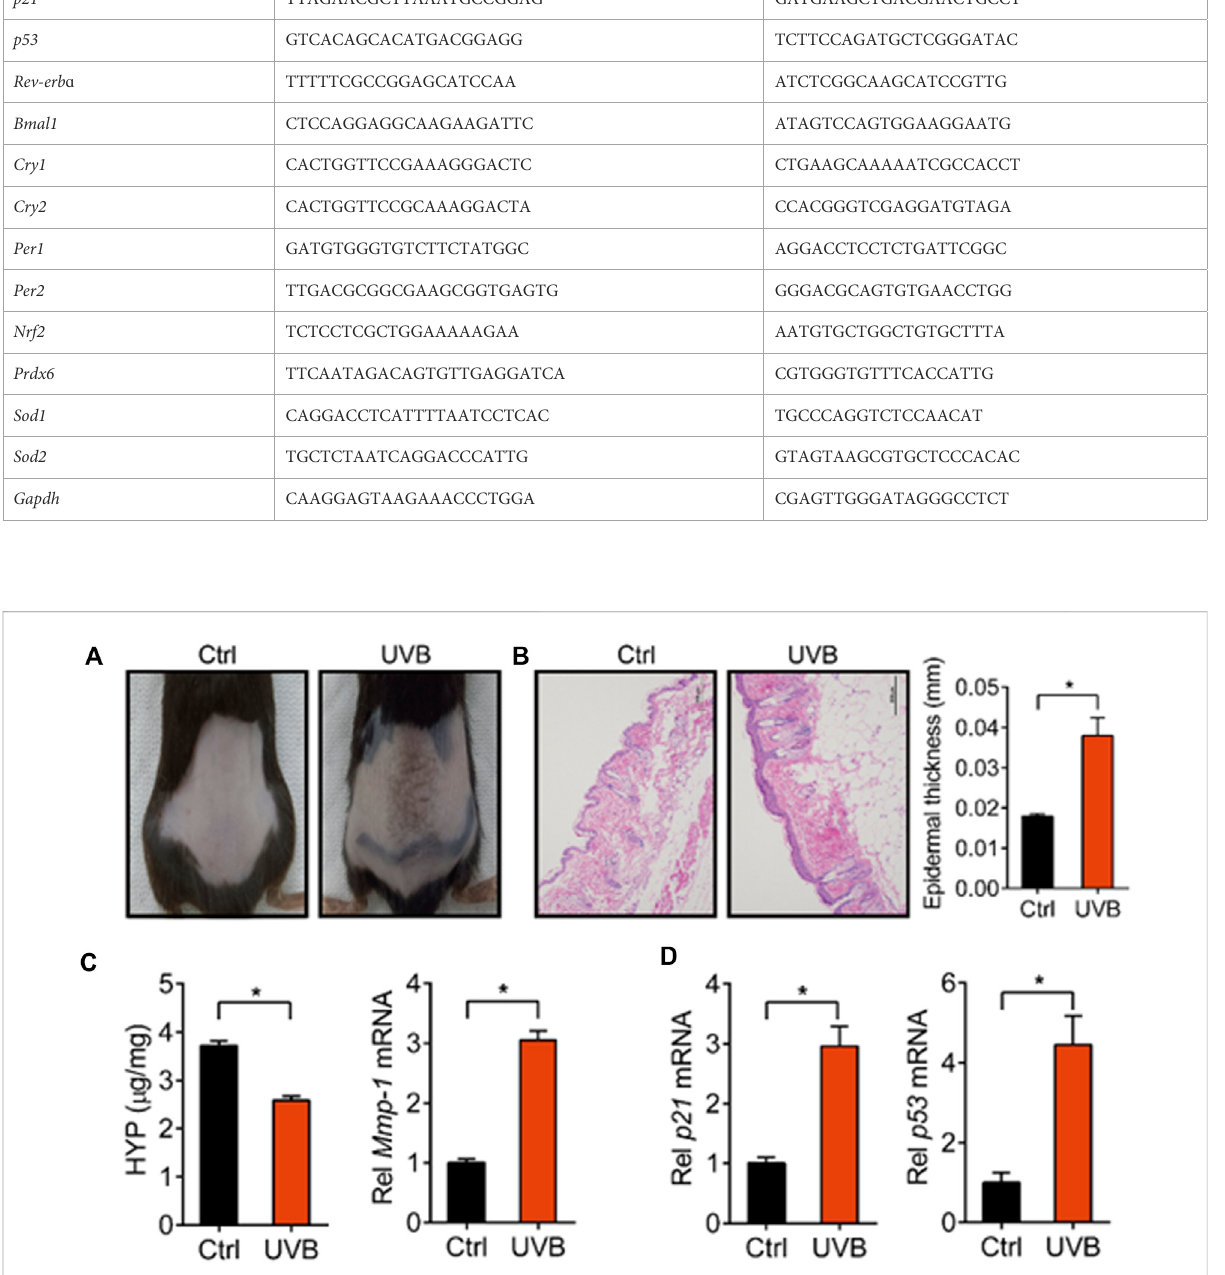
FIGURE 1 Characterization of UVB-induced skin aging model. (A) Skin photographs taken after irradiating the back of mice with UVB for 45 d. (B) Representative images of H&E staining and quantitative analysis of the epidermal thickness. Scale bar: 200 µm. (C) Content of HYP and expression level of Mmp-1 mRNA in the skin. (D) Expression levels of p21 and p53 mRNA in the skin. Data are presented as mean ± SD ( n = 6). * p < 0.05. Ctrl,